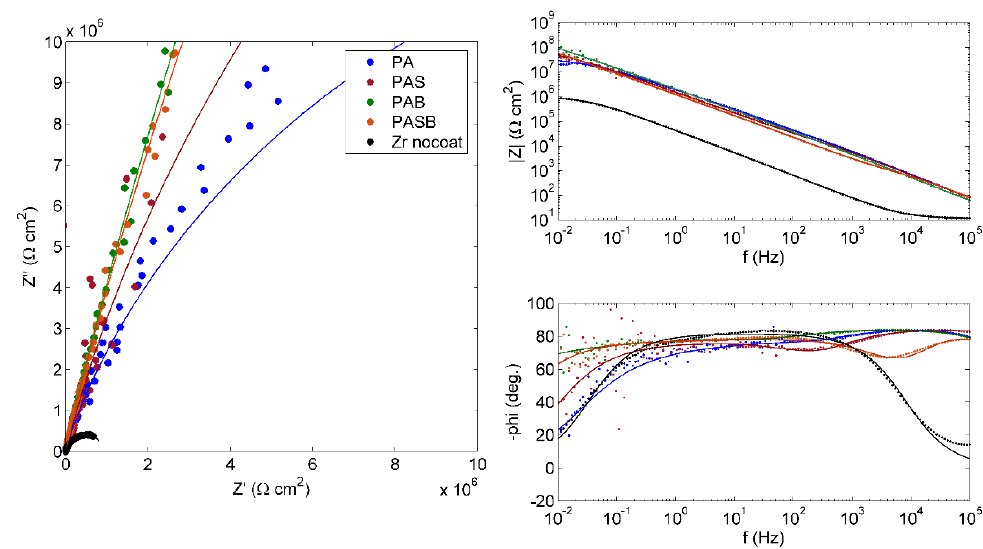
Figure 9. Nyquist and Bode plots for the EIS of the uncoated and PEO-coated samples in Ringer’s solution.